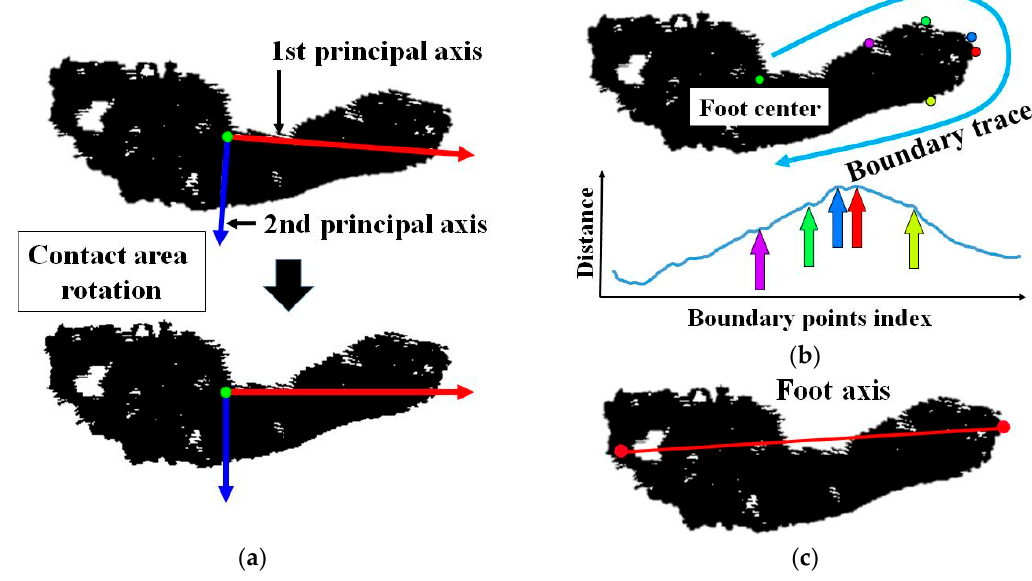
Figure 7. Key point detection process: ( a ) contact region alignment using PCA, ( b ) center of heel detection using boundary tracing, ( c ) definition of the foot axis as a line between the central points of the heel and second toe. Algorithm 2 Procedures of Foot Axis Detection